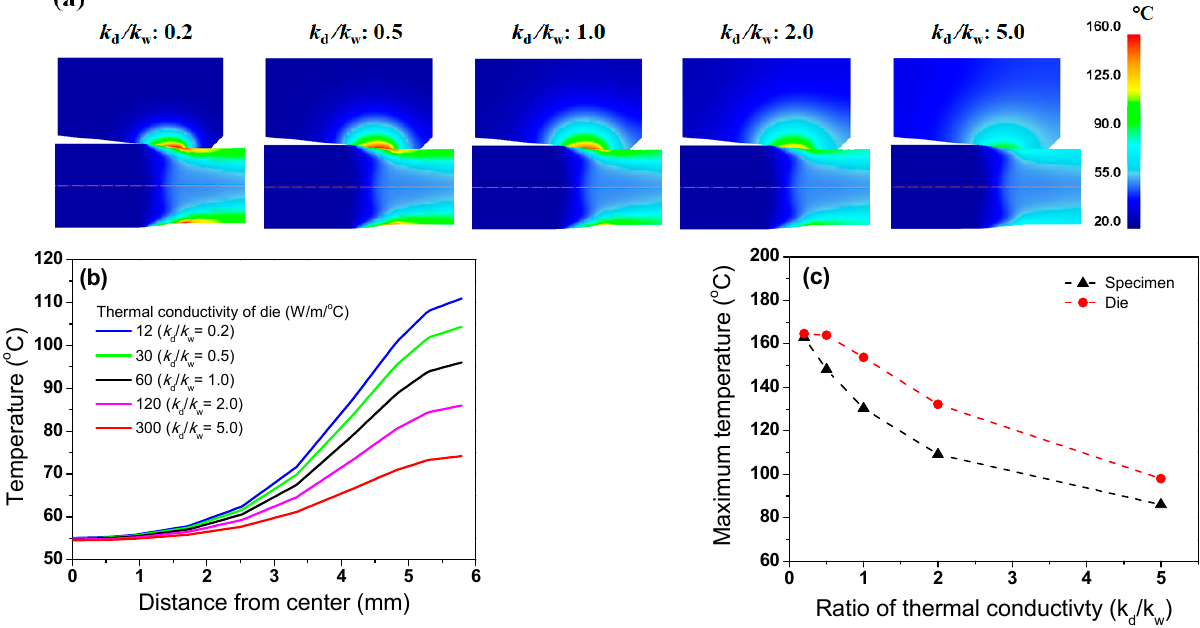
Figure 6. Comparison of temperature ( a ) contours and ( b ) profiles along radial direction of wire at die exit; ( c ) T max of wire and die vs. thermal conductivity of die.